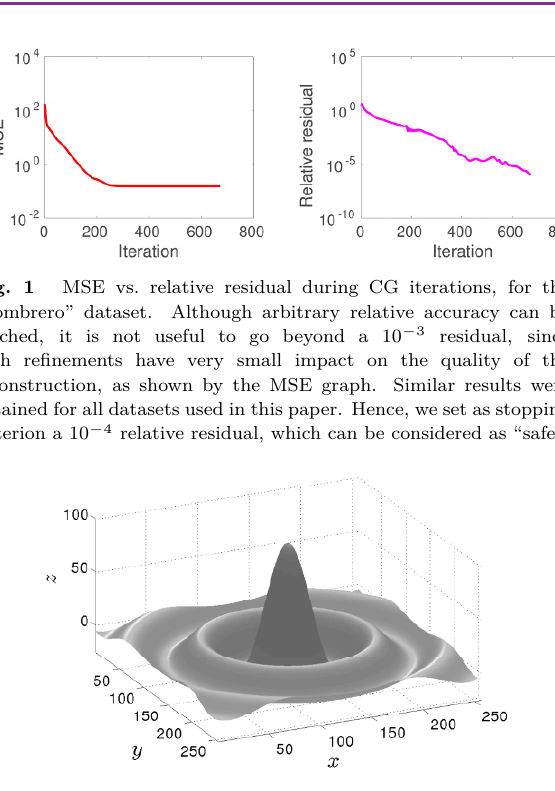
“Sombrero” surface (256 × 256) used in this experiment, whose gradient can be calculated analytically. Note that the depth values are periodic on the boundaries.